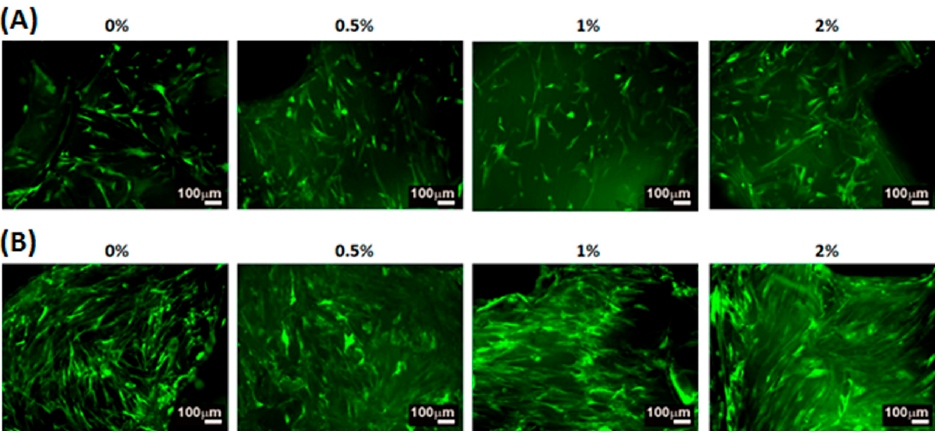
Figure 7. The fluorescent images of hWJMSCs cultured on the PU/HA hybrid scaffolds for ( A ) 1 and ( B ) 5 days.